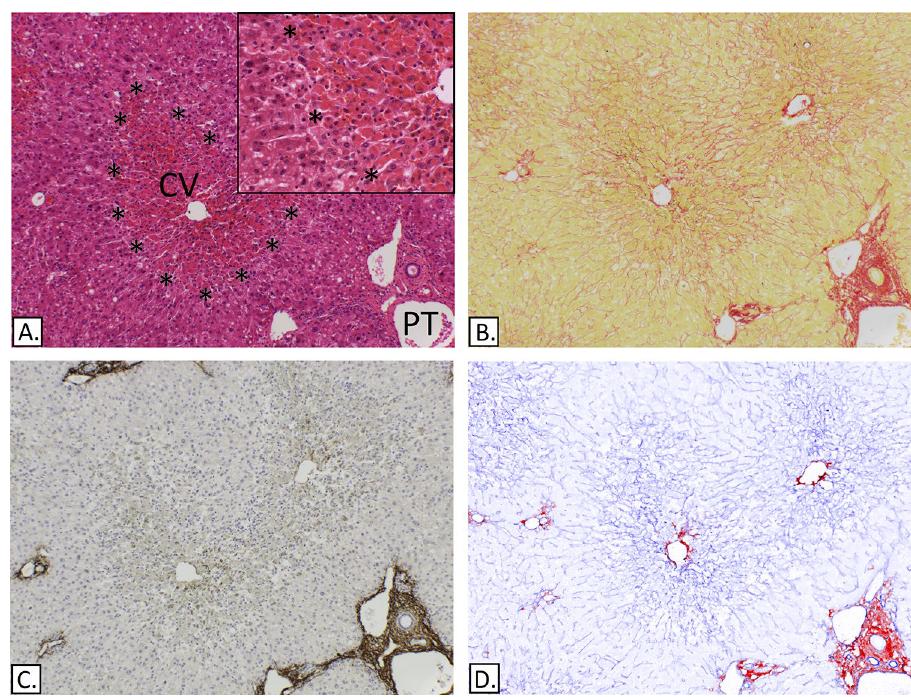
Figure 2. Liver from a patient with a paracetamol overdose. The images show confluent necrosis sparring peri- portal hepatocytes without collapse or change in composition of the perisinusoidal ECM. There is no ductular reaction. ( A ) H&E, confluent necrosis (demarcated by asterisk). ( B ) Picro-Sirius red. ( C ) IHC-Elastin, (ab9519). ( D ) IHC-collagen I (ab6308) in red & collagen III (ab7778) in blue, spectrally unmixed channels from Nuance camera + software. Collagen I and elastin fibre bundles are restricted to portal tracts (PT). And collagen I marks the centrilobular hepatic venules